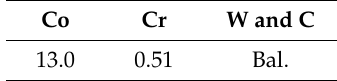
Table 1. Chemical composition of the WC-Co cemented carbide (wt %).